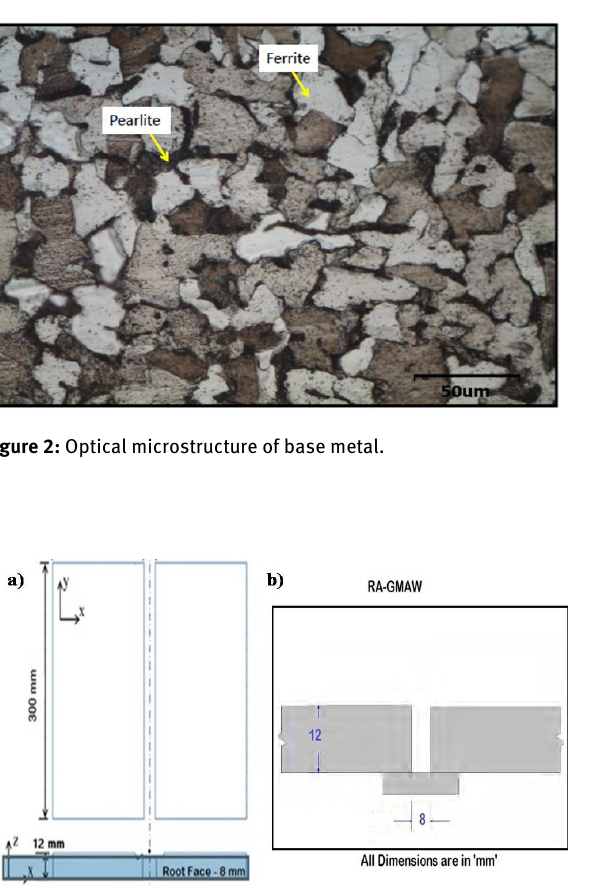
Figure 3: Configuration of weld joint: a) top view, b) side